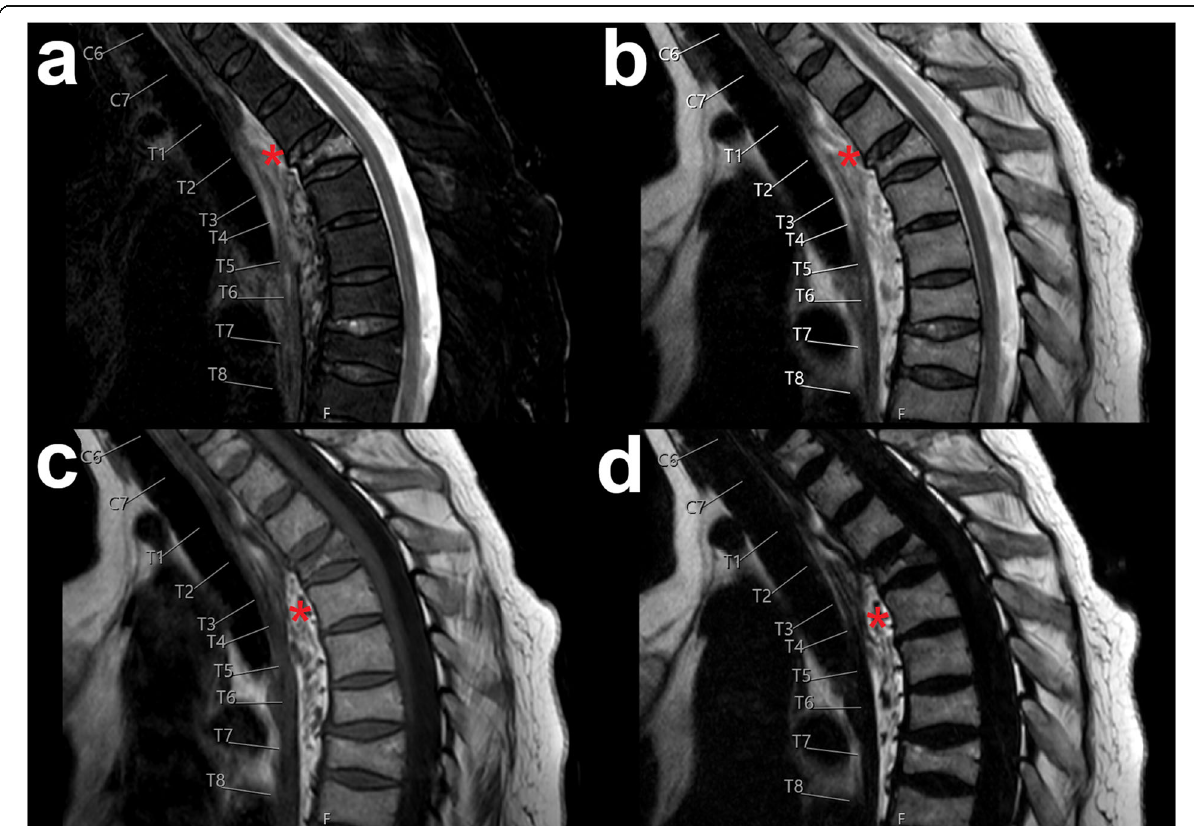
( a ), in-phase images ( b ), and fat-only images ( d ) of the sagittal T2-weighted DIXON sequence, together with a sagittal T1-weighted sequence ( c ). The patient had suffered a traffic accident and showed a thoracic prevertebral haematoma spanning from T1 to T8 (red asterisks) combined with an acute vertebral fracture